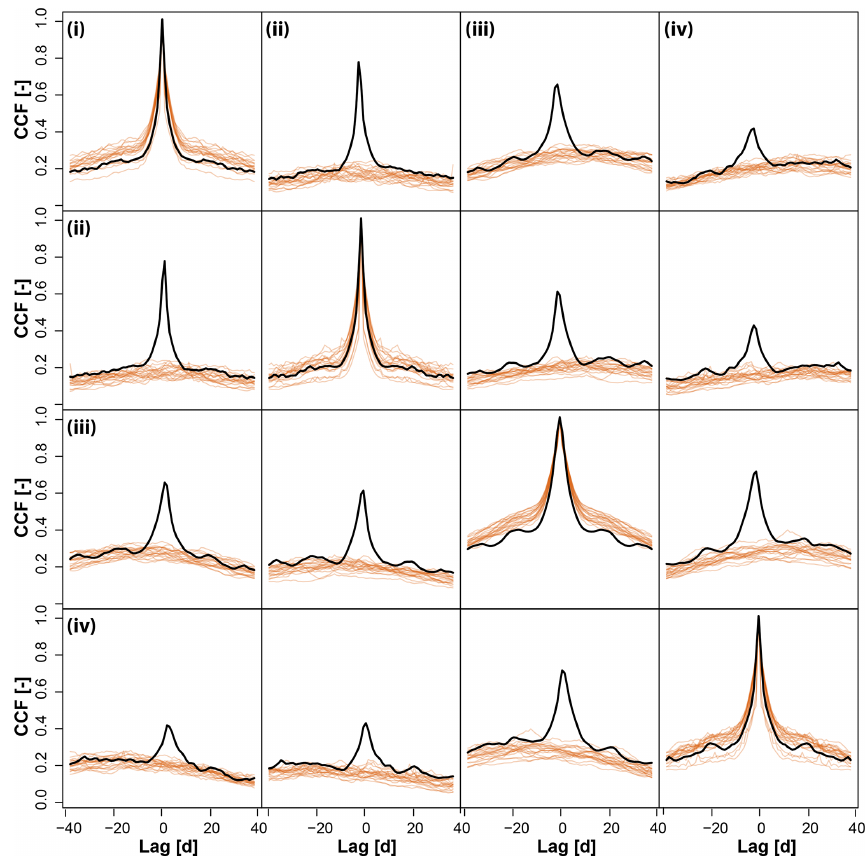
Figure A1. Comparison of observed (black) and simulated (orange) cross-correlation functions (ccfs) for the daily discharge values for pairs of stations in the set of four catchments (i–iv) in the Pacific Northwest. Twenty simulations were generated for each site individually, neglecting spatial dependence.